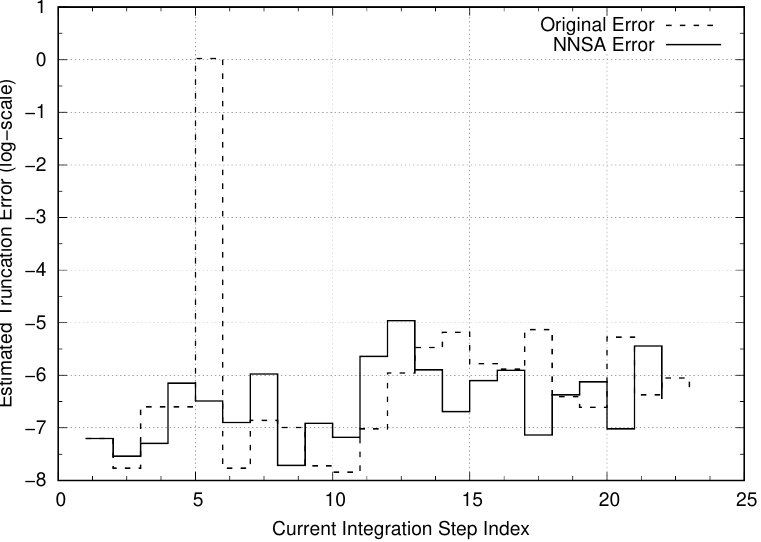
Figure 5. Comparison of Local Integration Error for Standard method and